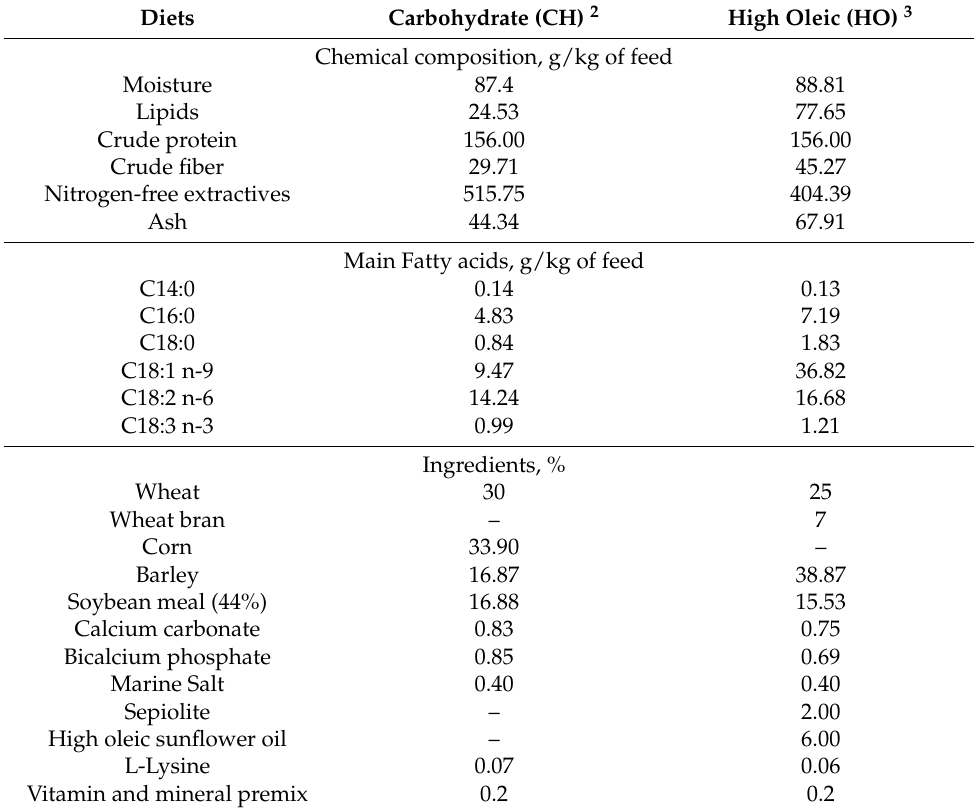
Table 1. Calculated analysis 1 , fatty acid composition and ingredients of the experimental